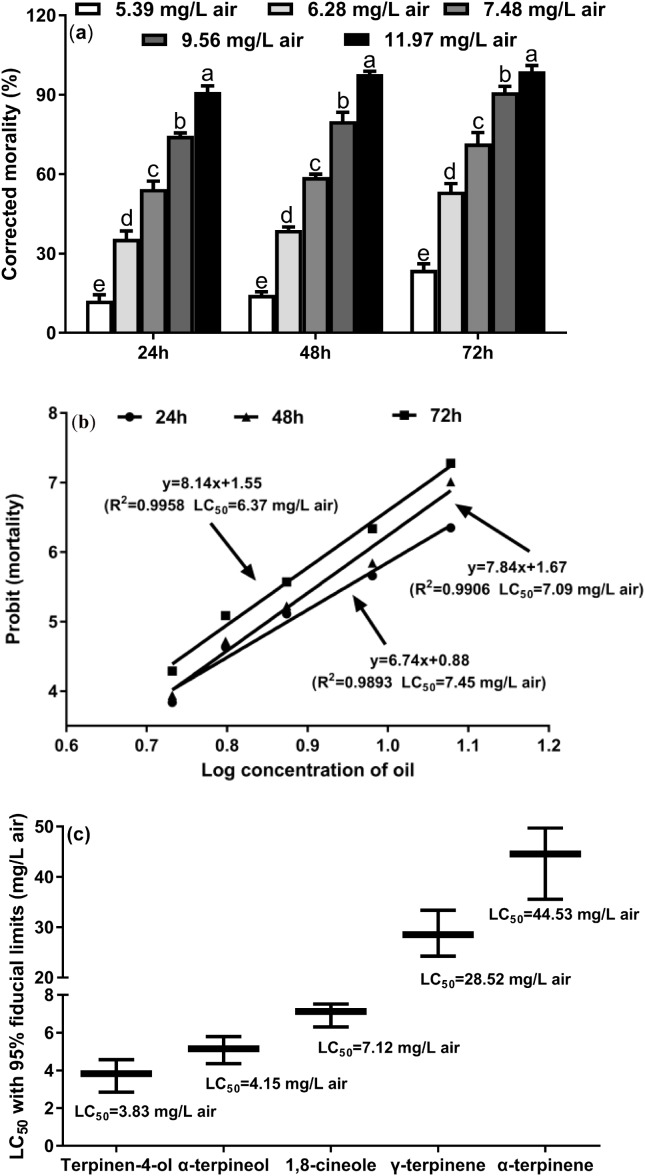
Fumiganttoxicity of M. alternifolia essential oil (A) and its constituents (C) against T. confusum adults and the corresponding regression analysis (B).Results are reported as mean ± SE (calculated from three independent experiments). The LC50 values were subjected to probit analysis (Fong et al., 2016). Different lowercase letters at the top of the columns mean significant differences at a p-value of 0.05. The error in Fig. 3C represents the 95% fiducial limits.